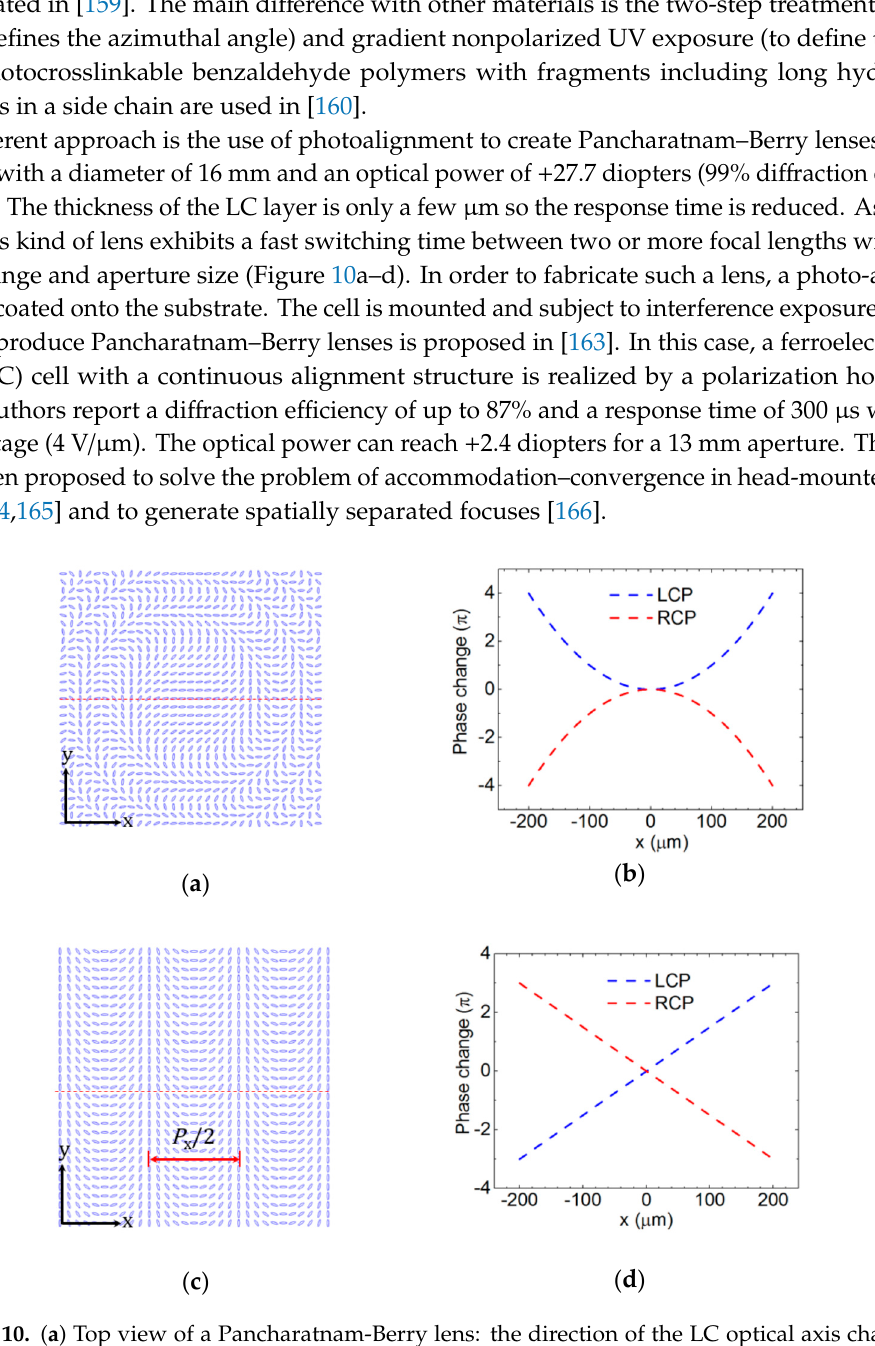
Figure 10. ( a ) Top view of a Pancharatnam-Berry lens: the direction of the LC optical axis changes radially. ( b ) The corresponding phase change along the dashed lines in (a). ( c ) Top view of a Pancharatnam-Berry deflector: the direction of the LC optical axis changes longitudinally. ( d ) The corresponding phase change along the dashed lines in (c). Reprinted with permission from [162].